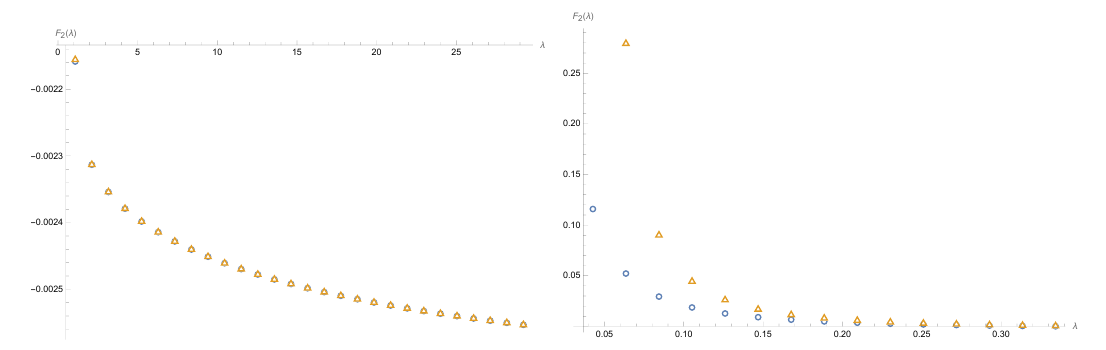
Figure 2 . The genus-2 free energies (3.30) (blue circles) and (3.34) (yellow triangles) for different values of the ’t Hooft coupling: 1